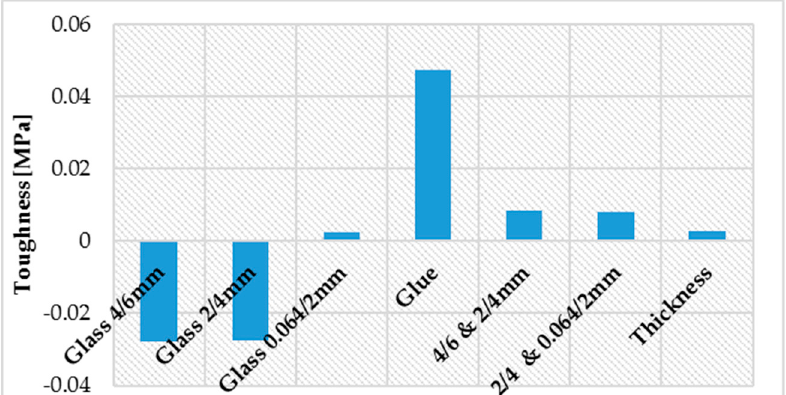
Figure 7. Influence of each mix-design variable on the toughness.